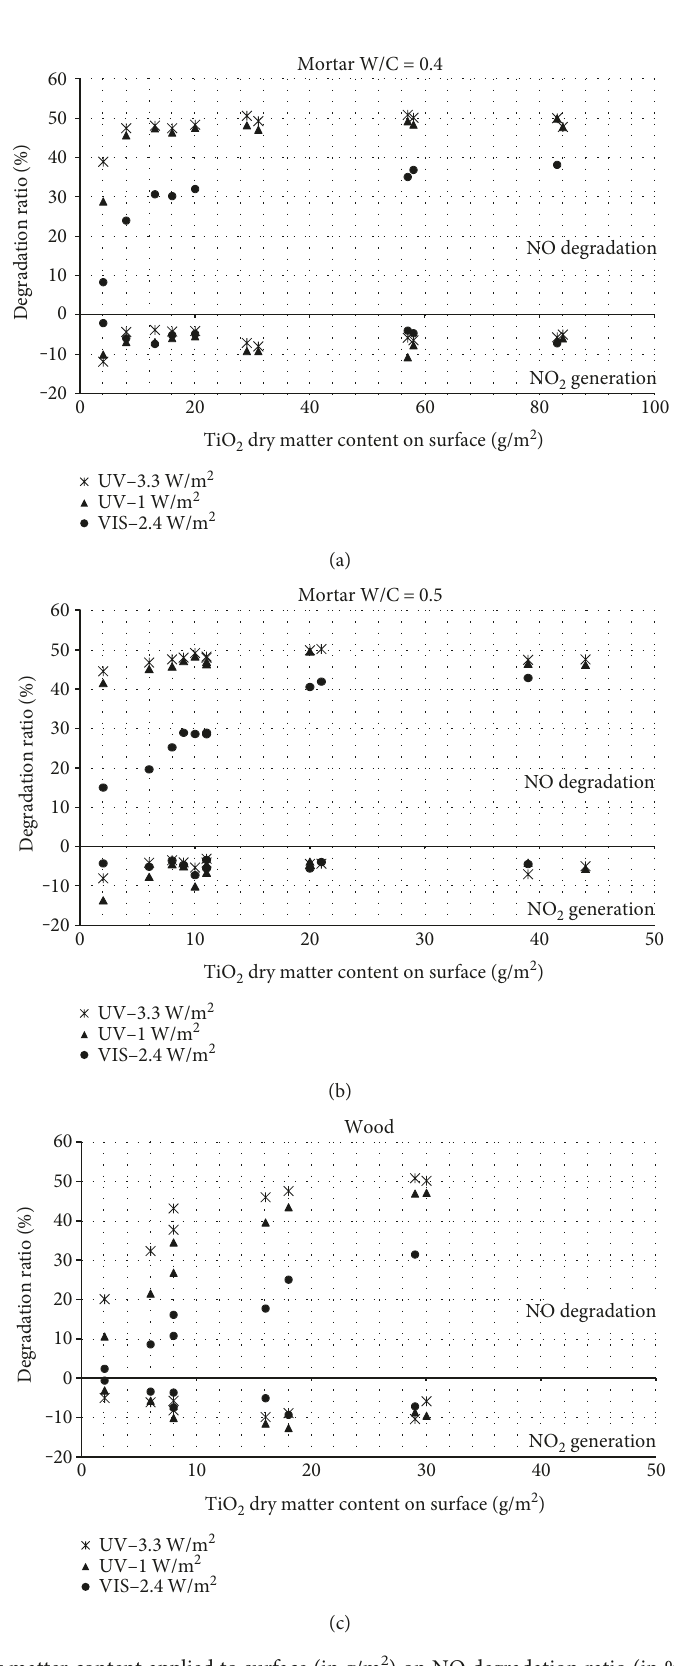
Figure 9: In fl uence of TiO dry matter content applied to surface (in g/m 2 ) on NO degradation ratio (in %) for each substrate under three 2 di ff erent illumination conditions (the NO generation is also represented): (a) mortar W/C =0.4, (b) mortar W/C =0.5, and (c) 2